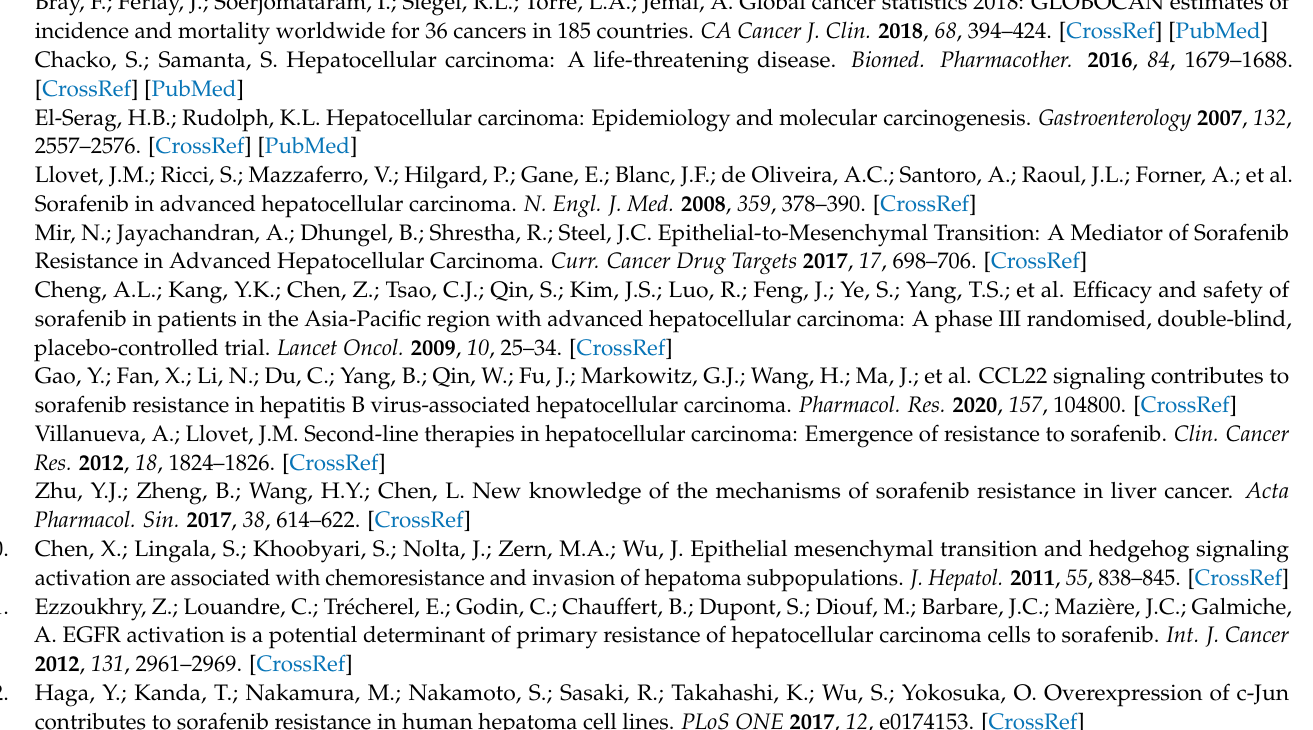
HCC cells, Figure S4: Silencing of PD-L1 in HCC cells, Figure S5: Drug combination of Sorafenib